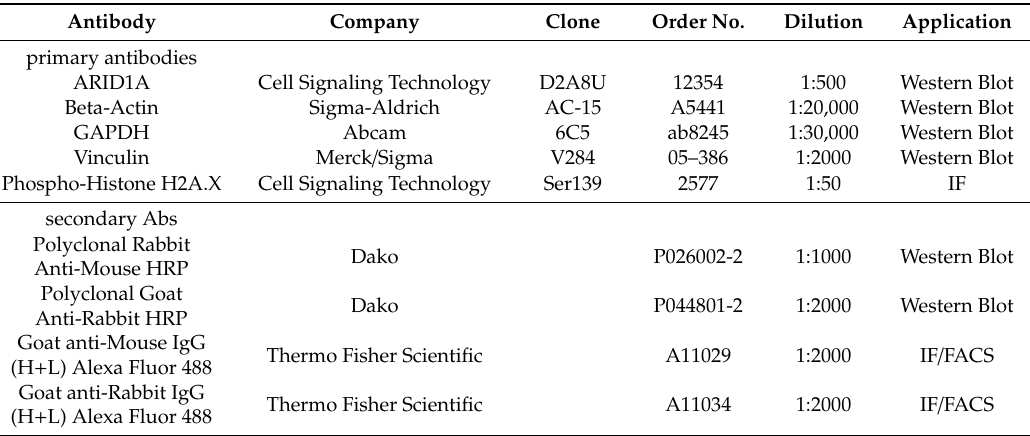
Table 2. Antibodies used in this